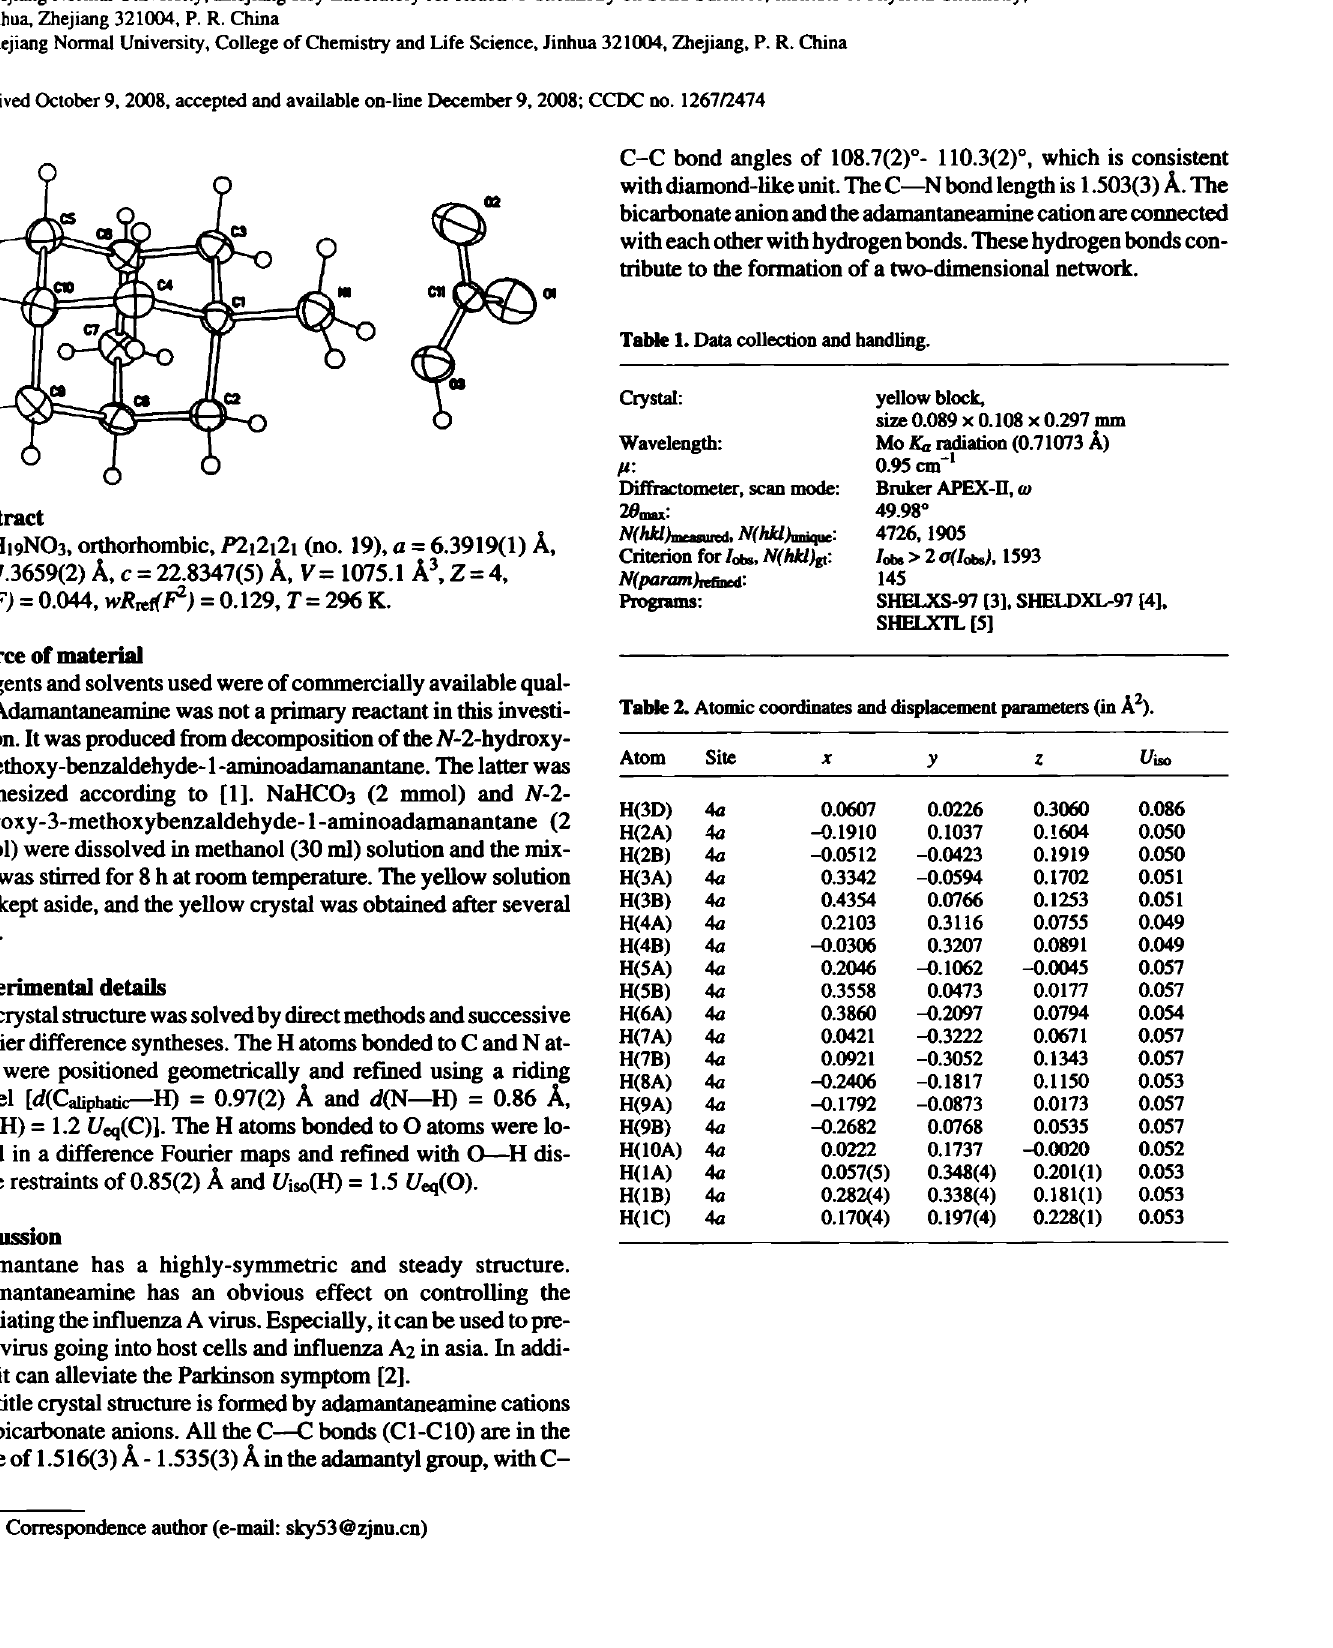
Table 1. Data collection and handling.